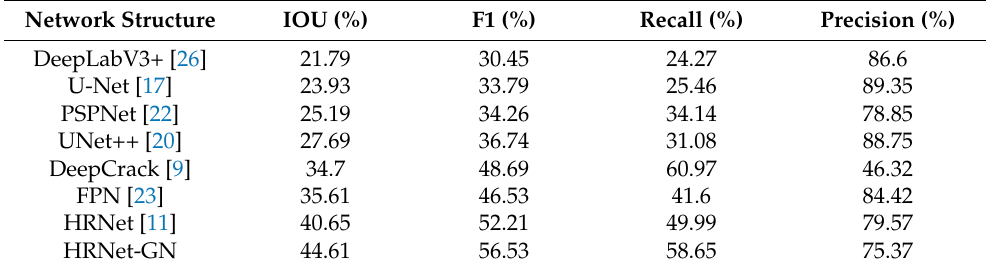
Table 1. Scores of different network structures trained with the BCE loss.